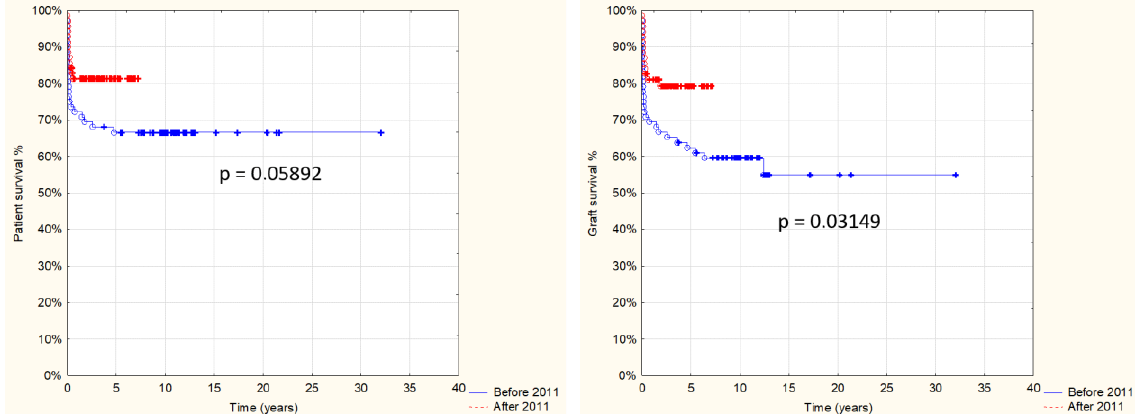
Figure 6. Patient and graft survival after AB0i LT, comparison between the periods 1986–2010 (Group 1) and 2011–2018 (Group 2).